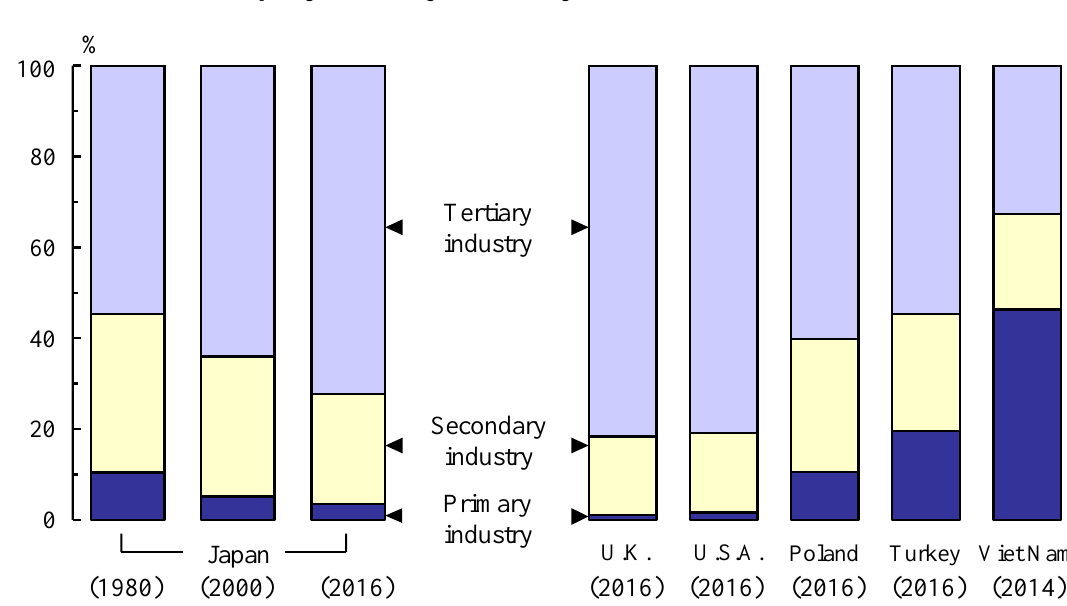
Structure of Employment by